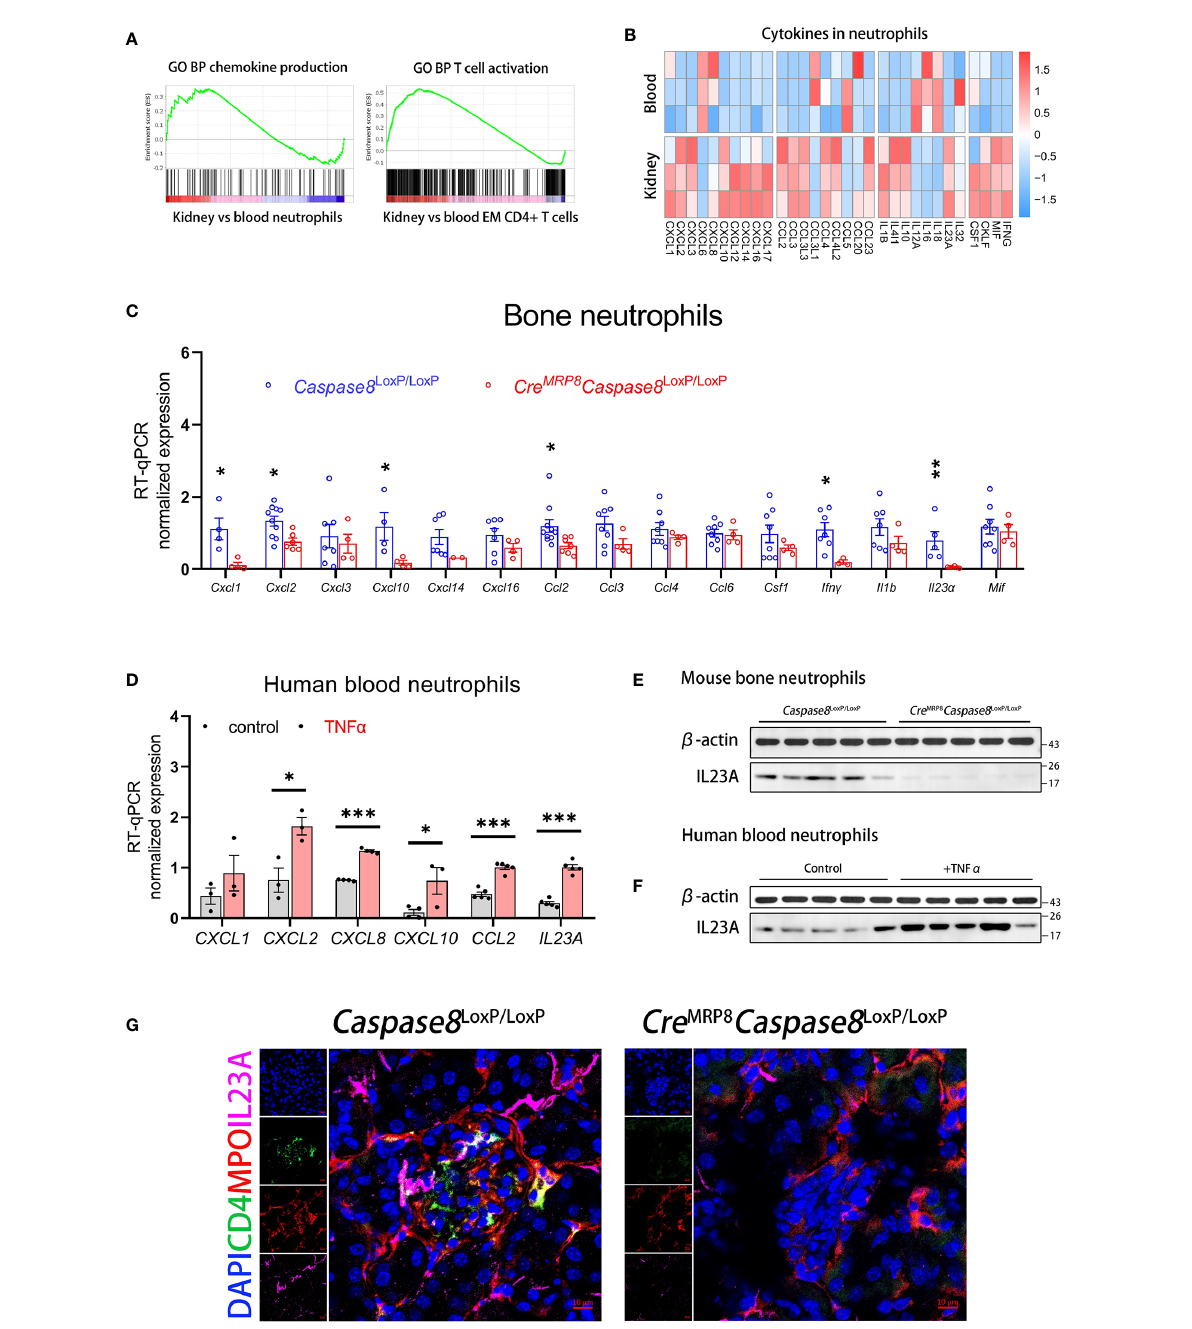
FIGURE 6 Neutrophils can produce IL23A for regulating CD4 + memory T cells through caspase-8 activation. (A) The GSEA plots of chemokine production in neutrophils and T cell activation in EM CD4+ T cells for kidney versus blood. (B) The heatmap comparing the expression of in fl ammation and immunoregulation factors between blood and kidney neutrophils. (C) RT-qPCR analysis of bone neutrophils for genes signi fi cantly up-regulated in kidney neutrophils between Caspase8 LoxP/LoxP and Cre MRP8 Caspase8 LoxP/LoxP mice. (D) RT-qPCR analysis of human blood neutrophils detecting gene expression changes after TNF a stimulation in vitro . (E) The western blot showing protein expression of IL23A in bone neutrophils from Caspase8 LoxP/LoxP and Cre MRP8 Caspase8 LoxP/LoxP mice. (F) The western blotting showing protein expression of IL23A in human blood neutrophils between control and TNF a groups. (G) The immuno fl uorescence shoots showing the relationship between IL23A (pink) secreted by neutrophils (red) and CD4 + T cells (green) in the kidney microenvironment of Caspase8 LoxP/LoxP and Cre MRP8 Caspase8 LoxP/LoxP mice. Scale bar, 20 m m. *P < 0.05, **P < 0.01, ***P <